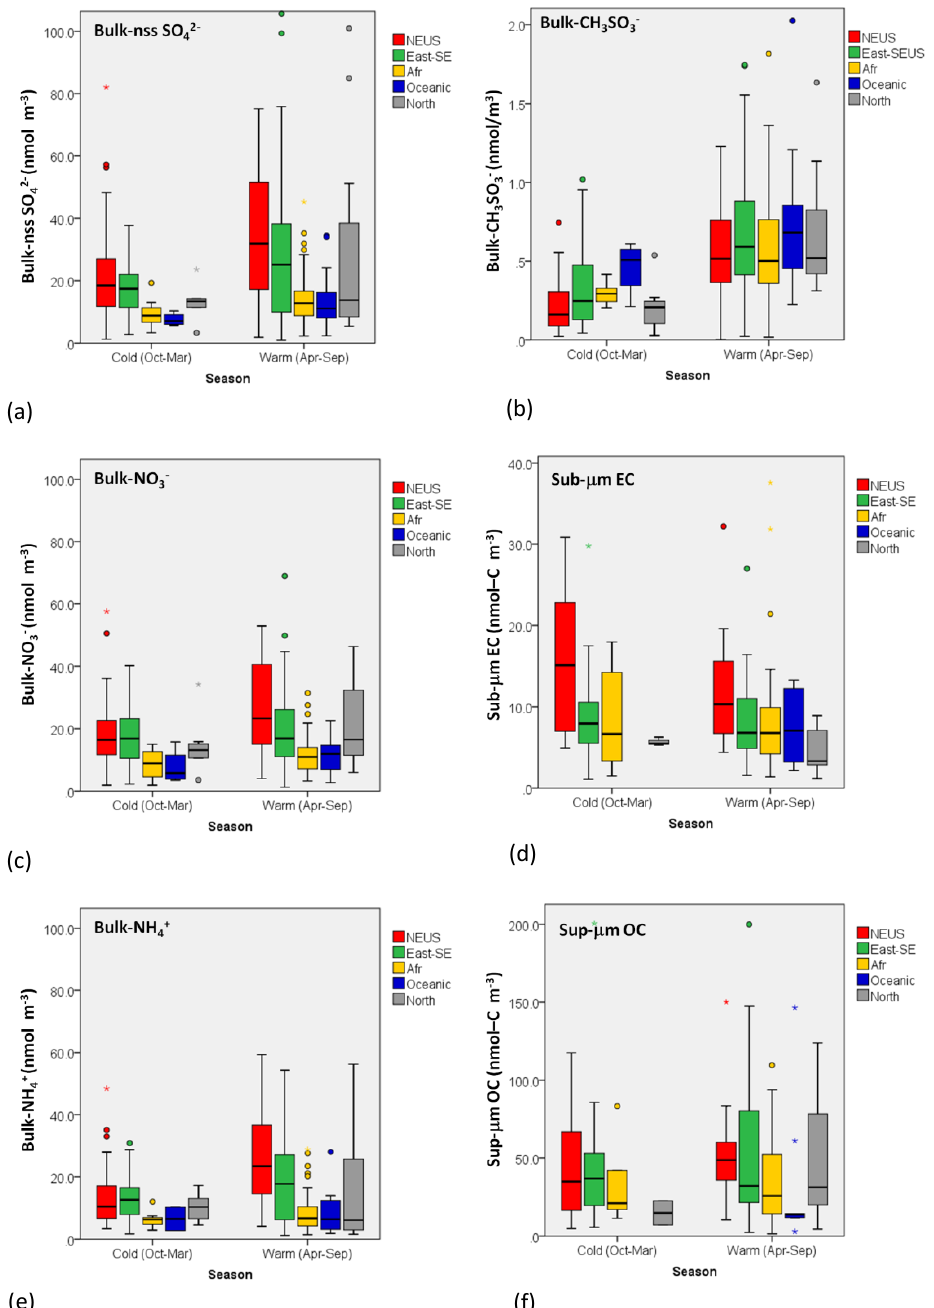
Fig. 3. Box and whisker plots depicting the 10th, 25th, 50th, 75th, and 90th percentiles and outliers (plotted individually with circles for 1.5 times the interquartile range, with asterisks for outliers 3 times the interquartile range) for (a) bulk nss SO 2 − NO − , (d) sub-µm EC, (e) bulk NH + , and (f) super-µm OC associated with each of the source region flow patterns by 3 4